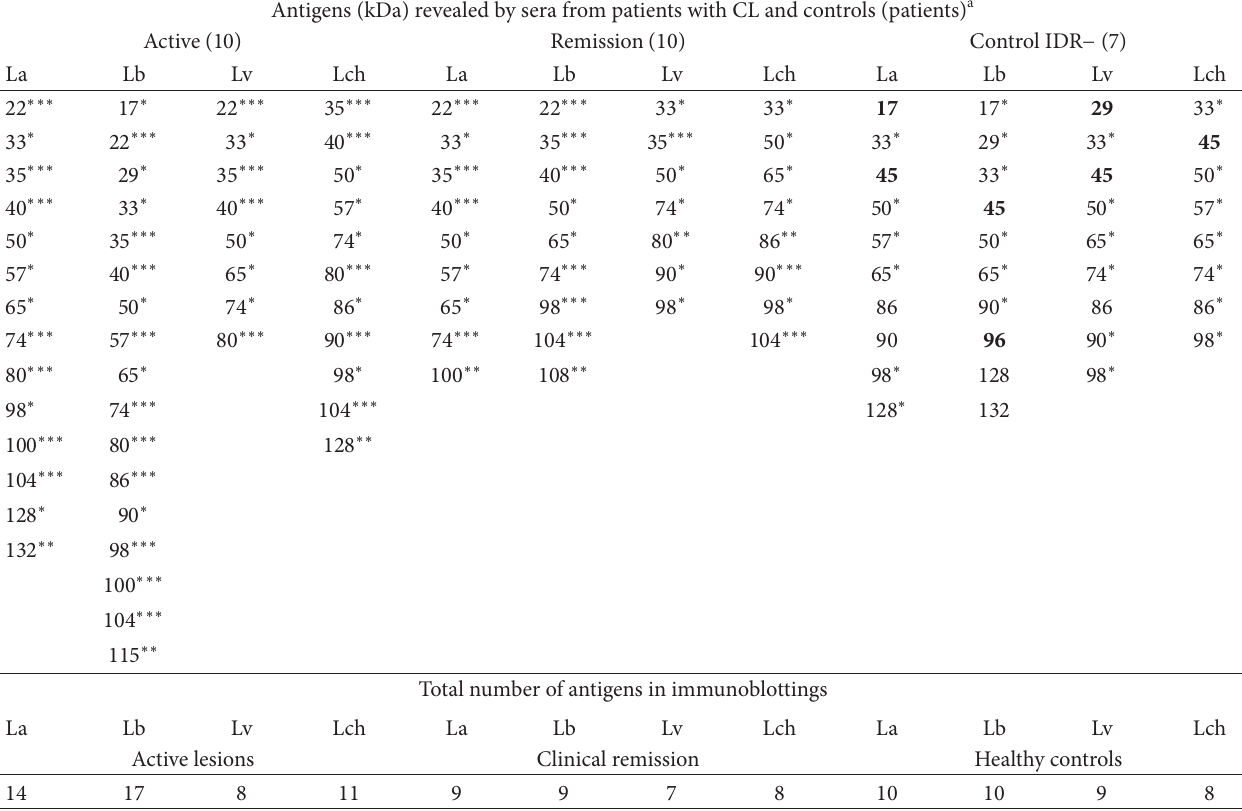
Table 7: Amastigotes antigens in immunoblottings, revealed by 80–100% sera, from patients with active CL, after clinical remission, and healthy controls.